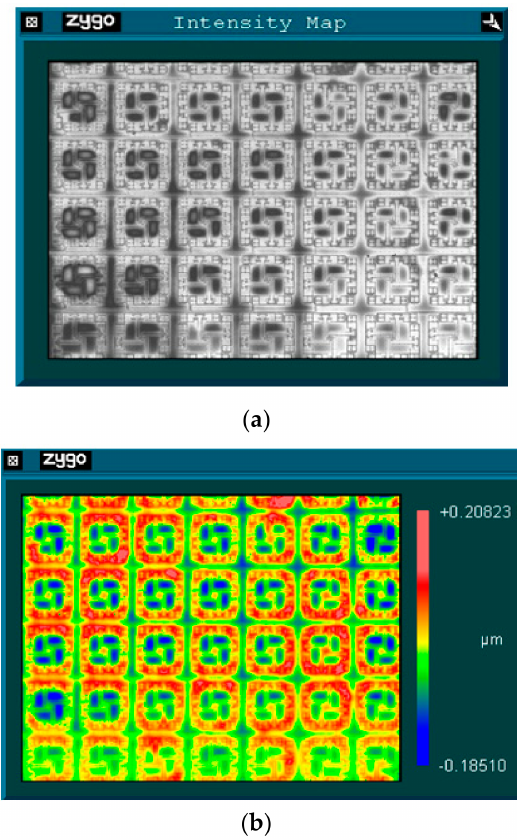
Figure 10. Schematic diagram of the micromirror after depositing 40 nm Cr membrane. ( a ) Interfer- ence figure. ( b ) Profile